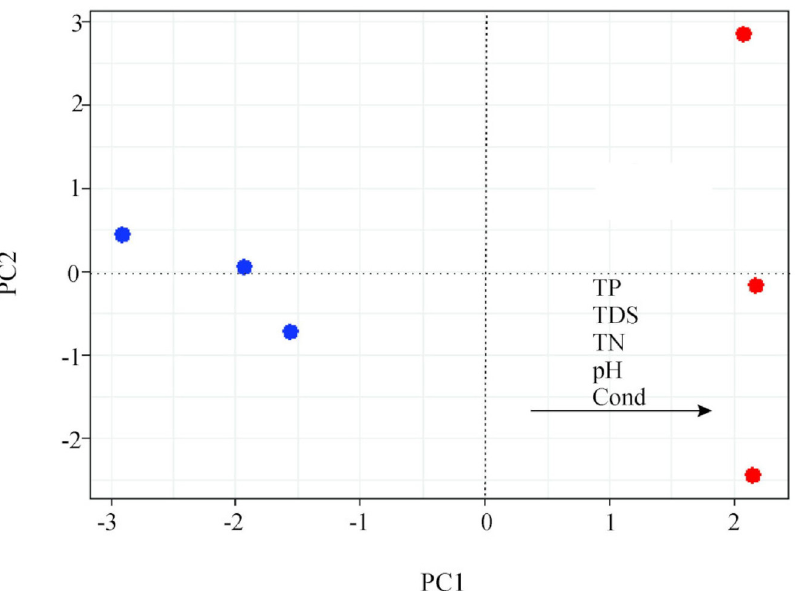
Table II. Diet of the fish during the experiment. Gross values and relative frequency of stomach items.